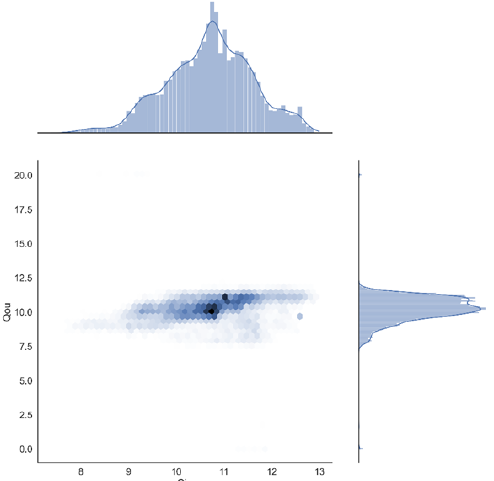
Figure 2. The distribution density plot of flow at both ends of the NG pipeline.